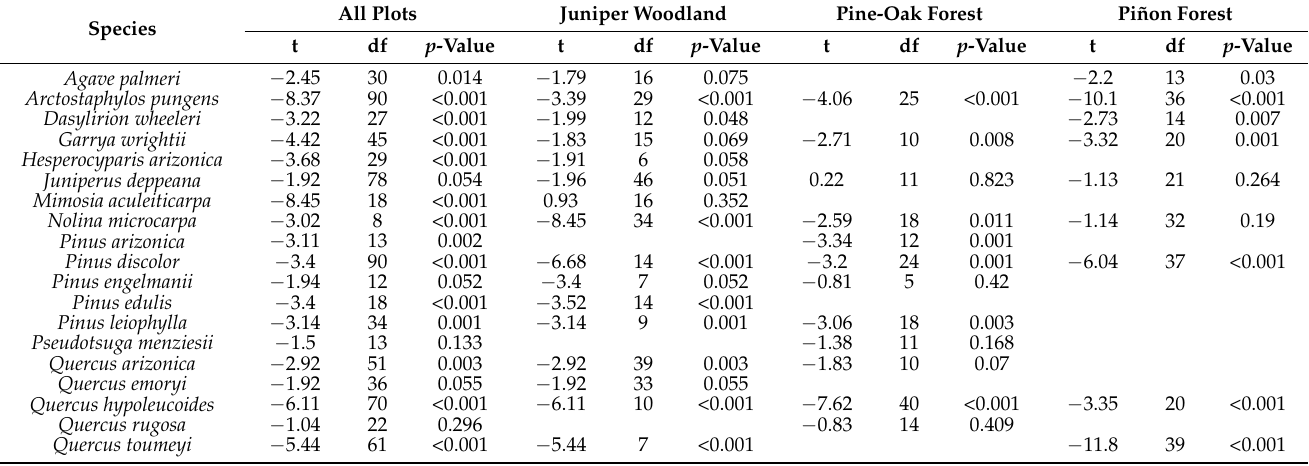
Table A1. Paired t -test significance table evaluating changes in woody plant species abundances over all sample plots, and for major species within each vegetation type in Chiricahua National Monument, Arizona, USA. The majority of woody plant species declined in abundance over the sampling interval.